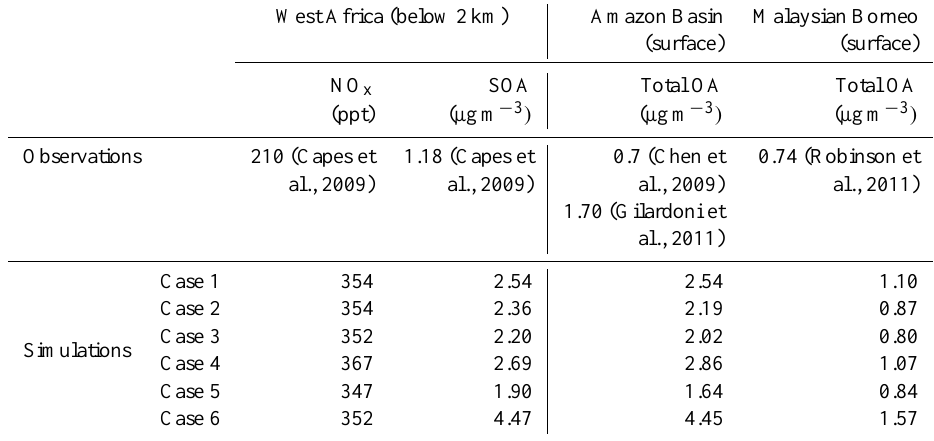
Table 7. Comparison of simulated OA and NO x with observations in tropical forested regions.